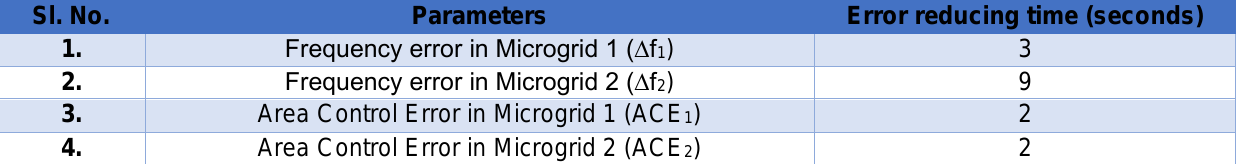
Table 4. Error reduction time of frequency error and Area Control Error in both the Microgrids Sl. No.